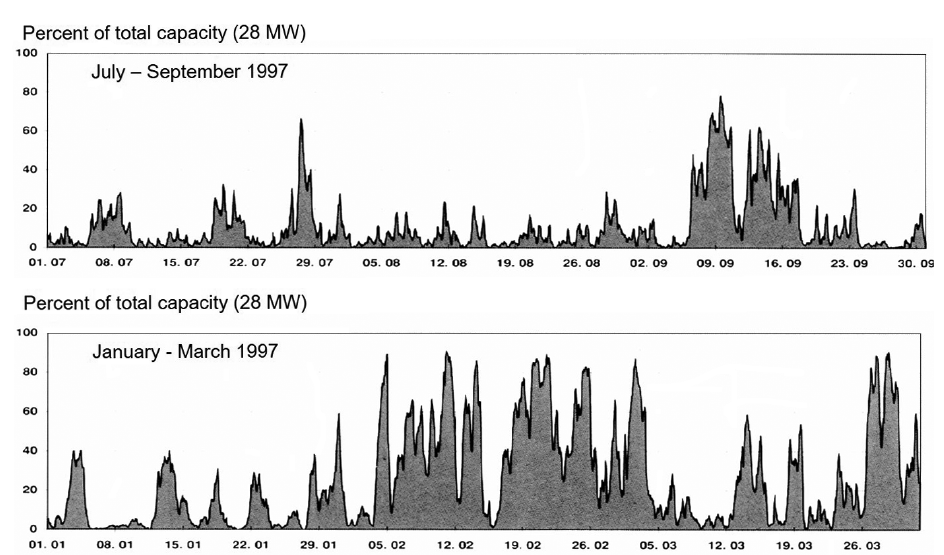
Fig. 6. – Load distribution —measurement